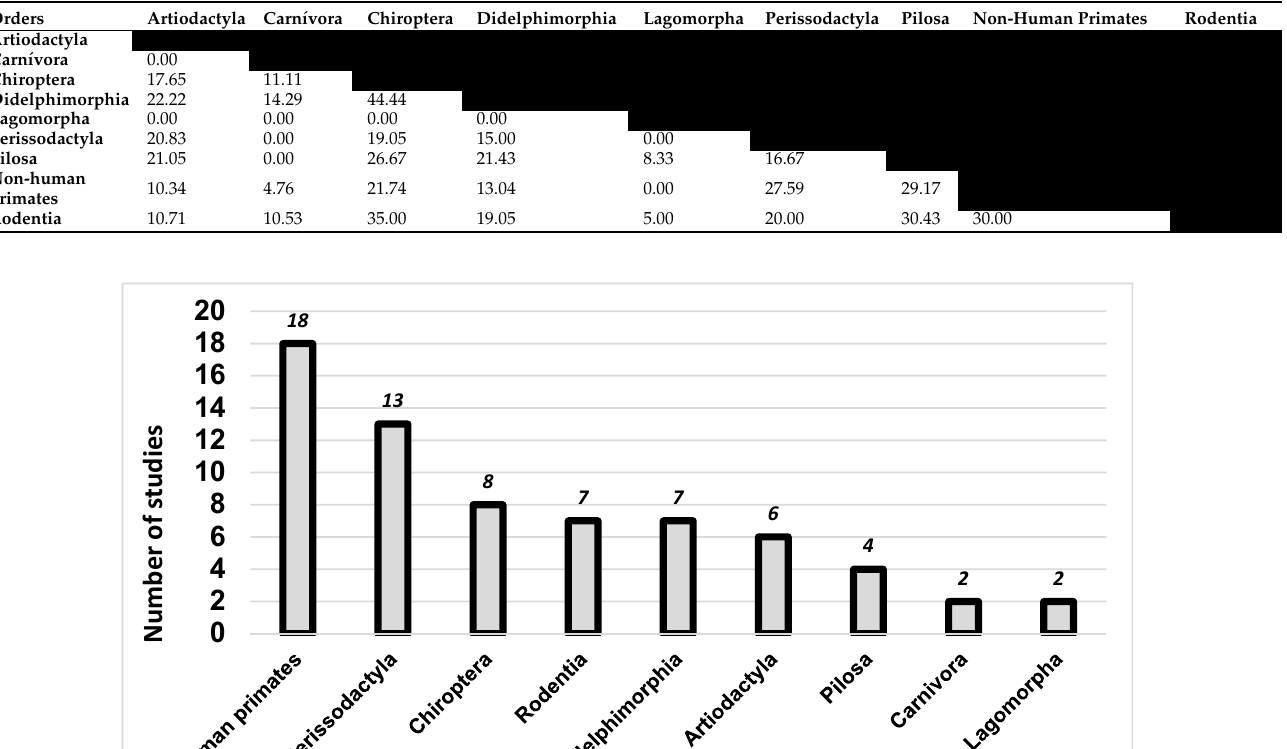
Figure 4. Arbovirus host network in mammals in the Neotropics. Legend: grey link: eomestic envi- ronment, black link: wildlife environment, pink link: zoological settings, grey circles: mammal or- ders, white circles: arbovirus. Note: Apeu virus—APEUV; Bunyamwera virus—BUNV; Bussuquara virus—BSQV; Cache Valley virus—CVV; Cacipacore virus—CPCV; Caraparu virus—CARV; Catu virus—CATUV; Changuinola virus—CGLV; Dengue virus; Madariaga virus—MADV; Western eq- uine encephalitis virus—WEEV; Flavavirus undetermined; Fort Sherman virus—FSV; Gamboa vi- rus—GAMV; Guama virus—GMAV; Guaroa virus—GROV; Icoaraci virus—ICOV; Ilheus virus— ILHV; Itaqui virus—ITQV; Jamestown Canyon virus—JCV; Madrid virus—MADV; Maguari vi- rus—MAGV; Mayaro virus—MAYV; Melao virus—MELV; Mojui dos Campos virus—MDCV; Murutucu virus—MURV; Oriboca virus—ORIV; Oropouche virus—OROV; Ossa virus—OSSAV; Punta Toro virus—PTV; Rocio virus—ROCV; Sant Louis encefalitis virus—SLEV; Tacaiuma virus— TCMV; UNA virus—UNAV; Utinga virus—UTIV; Venezuelan equine encephalitis virus—VEEV; Vesicular stomatitis, Indiana serotype virus—VSIV; Vesicular stomatitis virus, New Jersey sero- type—VSNJV; West Nile virus—WNV; Xingu virus—XINV; yellow fever—YFV; Zika—ZIKV; Rio Grande—RGV.